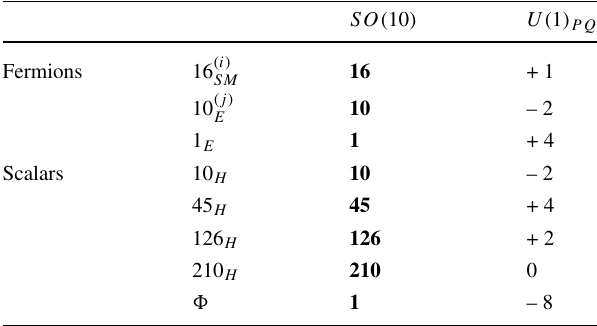
Table 1 Particle contents of SO ( 10 ) × U ( 1 ) PQ